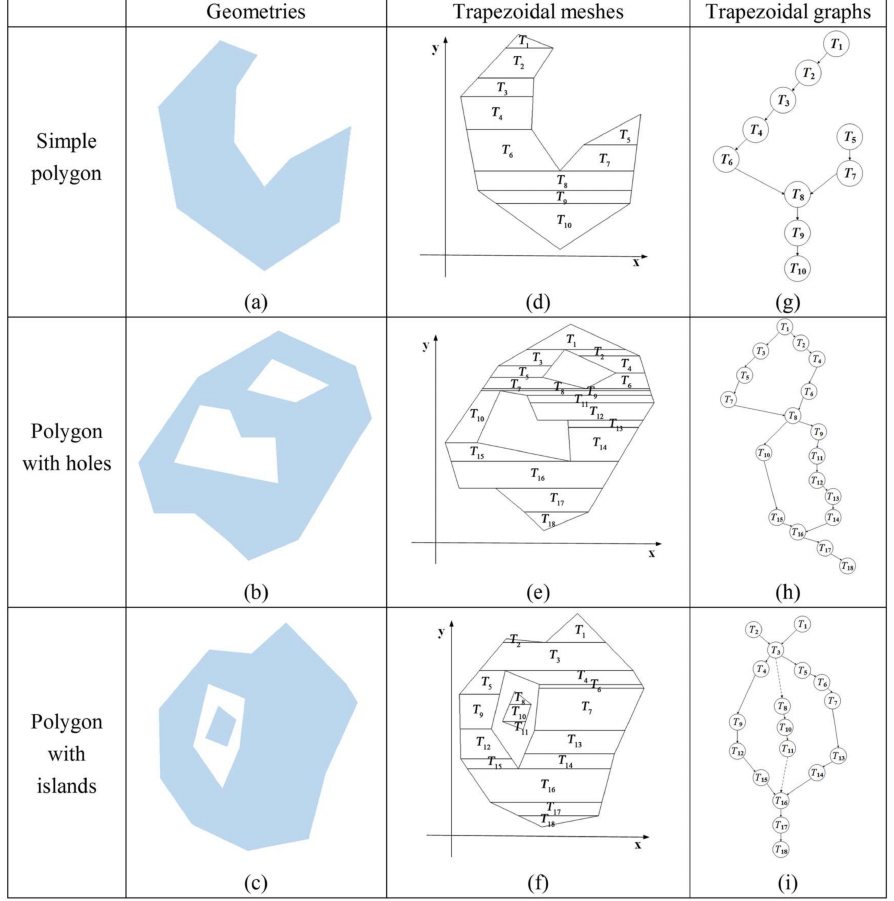
Figure 1. Three types of polygons, their trapezoidations and trapezoidal graphs. ( a ) is a geometry of a simple polygon, ( d ) is the tessellated result of ( a ), ( g ) is the trapezoidal graph of ( a ), ( b ) is a geometry of a polygon with holes, ( e ) is the tessellated result of ( d ), ( h ) is the trapezoidal graph of ( b ), ( c ) is a geometry of a polygon with islands, ( f ) is the tessellated result of ( c ), ( i ) is the trapezoidal graph of a simple polygon of ( d